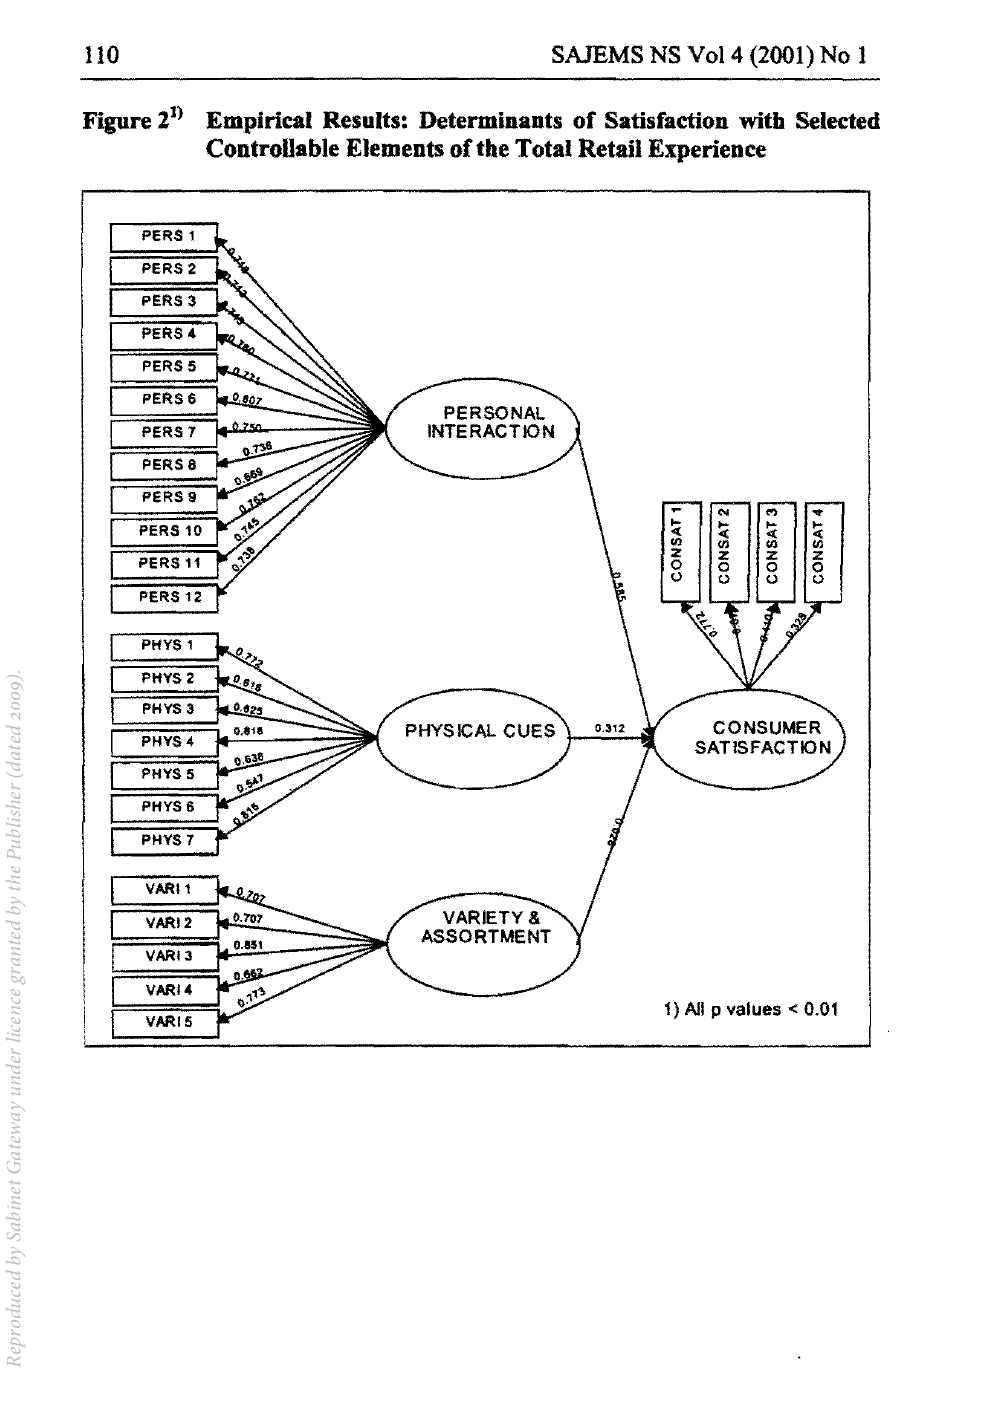
Figure 2 1 ) Empirical Results: Determinants of Satisfaction witb Selected ControUable Elements ofthe Total Retail Experience